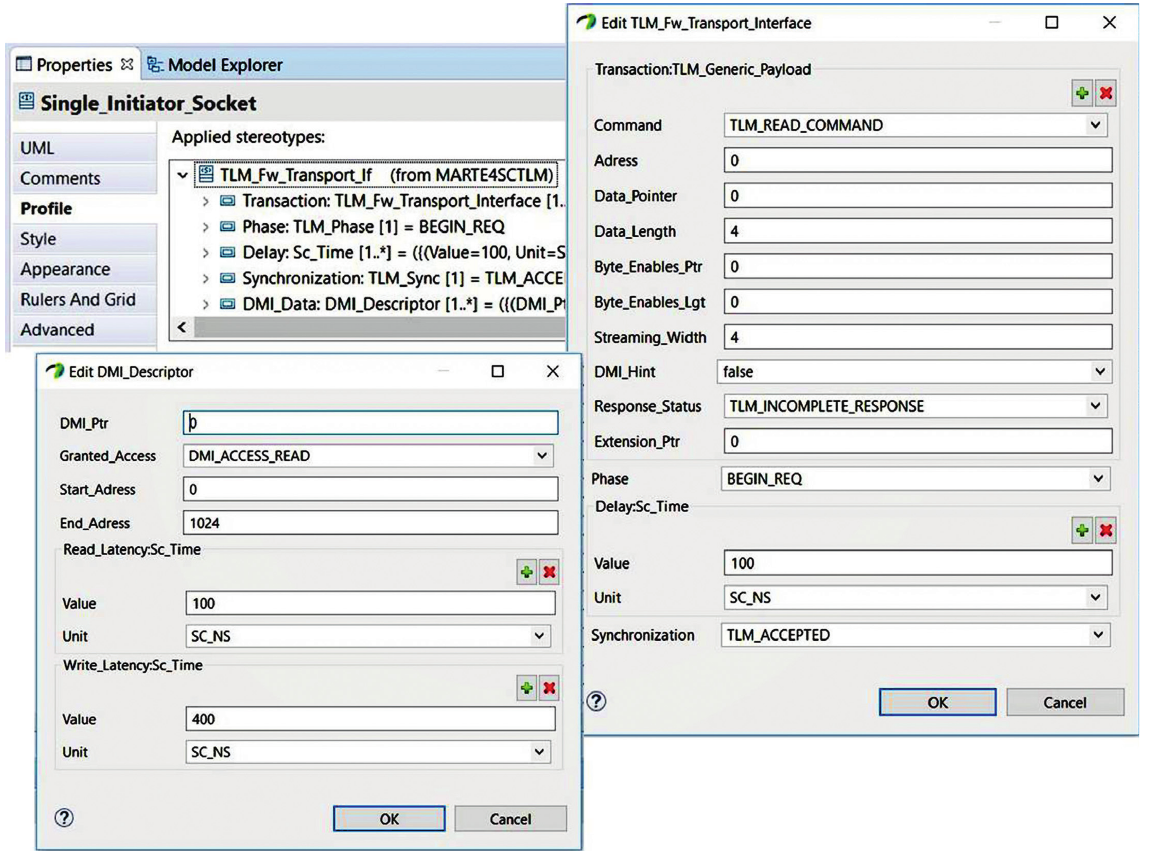
Figure 18: Assigning values to the TLM_Fw_Transport_If stereotype